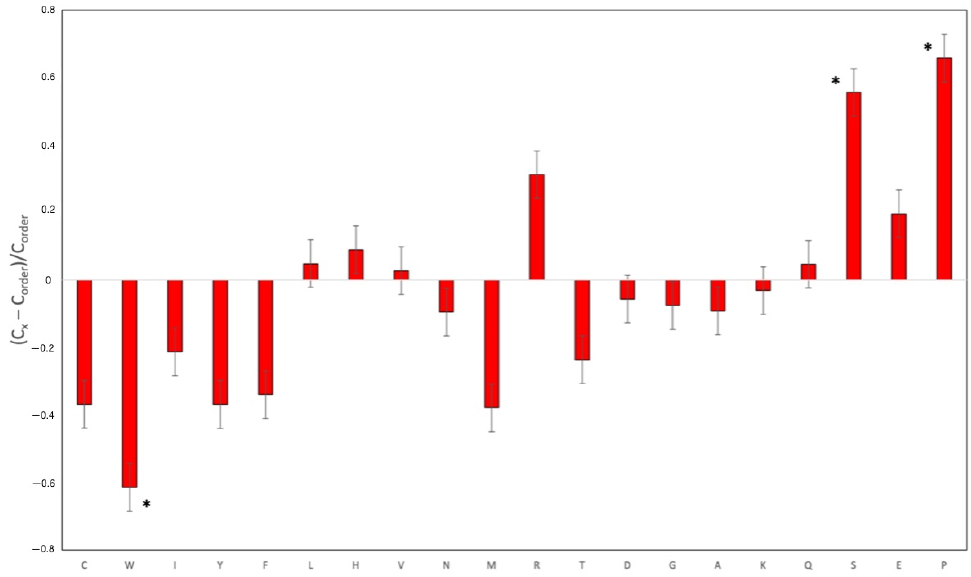
Figure 2. Amino acid composition profile of BAP1. The fractional difference is calculated as (Cx–Corder)/Corder, where Cx is the content of a given amino acid in the query set (BAP1), and Corder is the content of a given amino acid in the background set (Protein Databank Select 25). The amino acid residues are ranked from most order promoting residues ((i.e., cysteine (C), tryptophan (W), isoleucine (I), tyrosine (Y), phenylalanine (F), leucine (L), histidine (H), valine (V), asparagine (N), and methionine (M)) to most disorder promoting residues ((i.e., arginine (R), threonine (T), aspartate (A), lysine (K), glutamine (Q), serine (S), glutamate (E), and proline (P)). Positive values